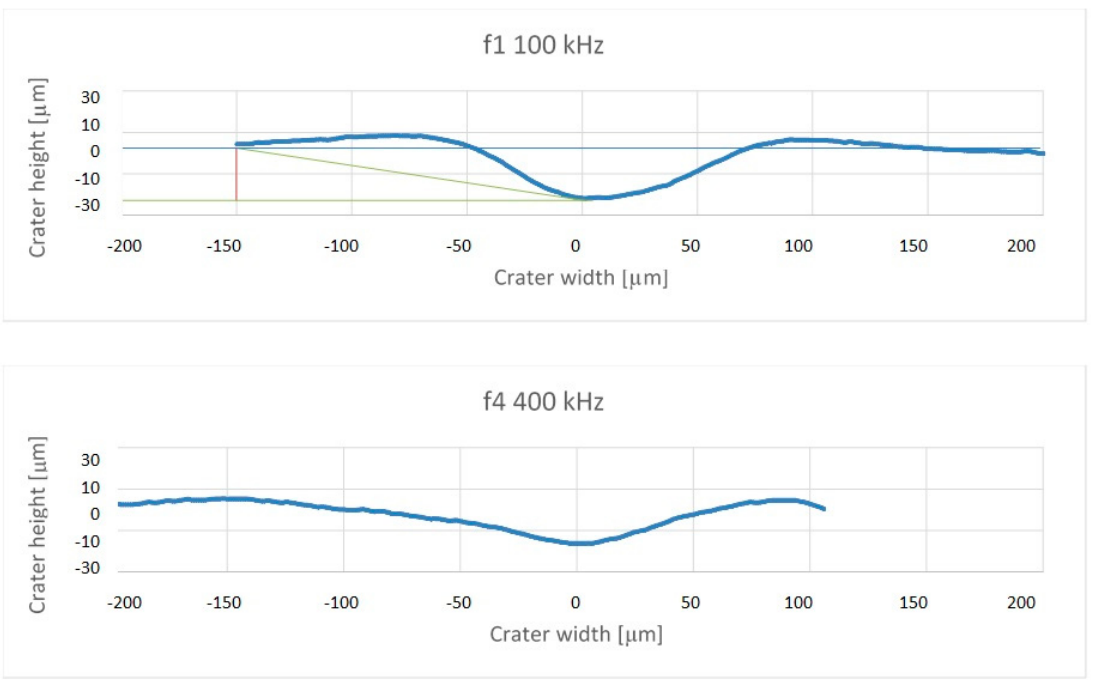
Figure 5. Crater profile of the aluminum sample scribed with sub-picosecond Yb:KYW laser (650 fs, 1030 nm).